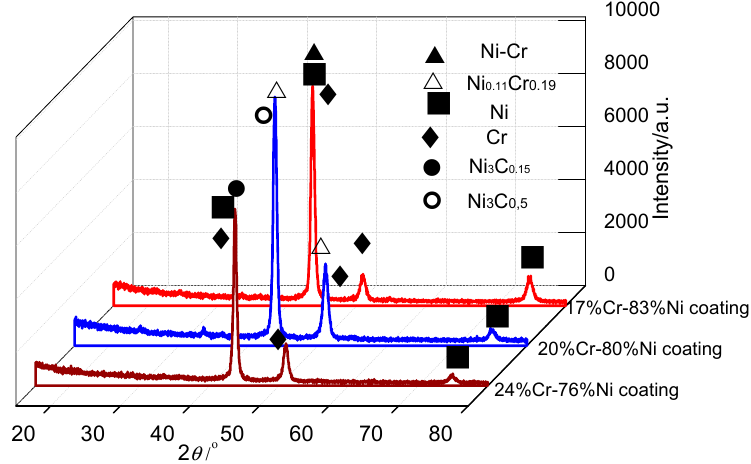
Figure 10. XRD patterns of Cr–Ni coatings with different mass ratios of Cr and Ni.